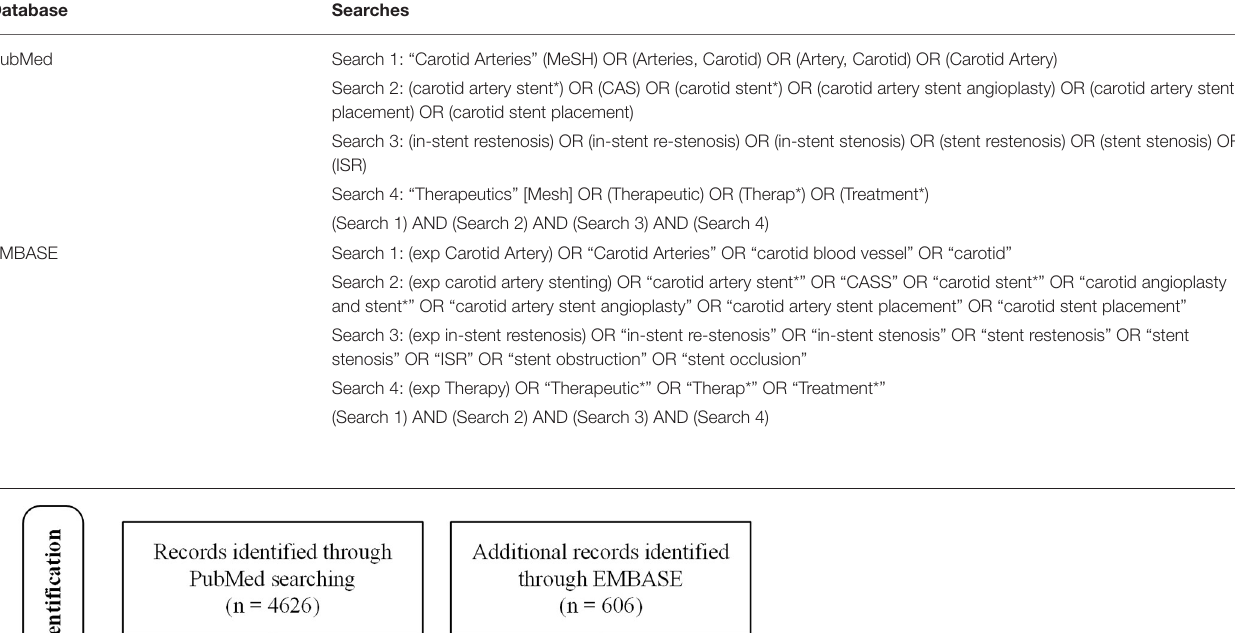
TABLE 1 | Search terms in PubMed and EMBASE.